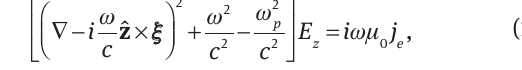
= ω = 0 and ξ = 0. p ,1 p ,2